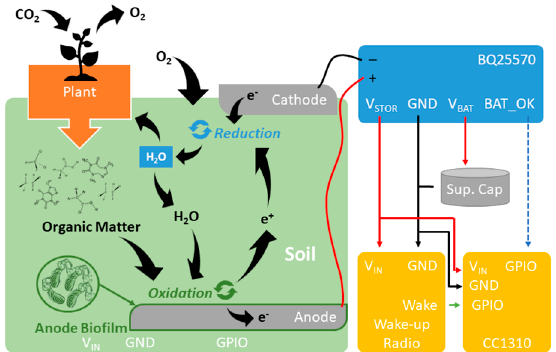
Figure 1. Block scheme of the proposed solution.